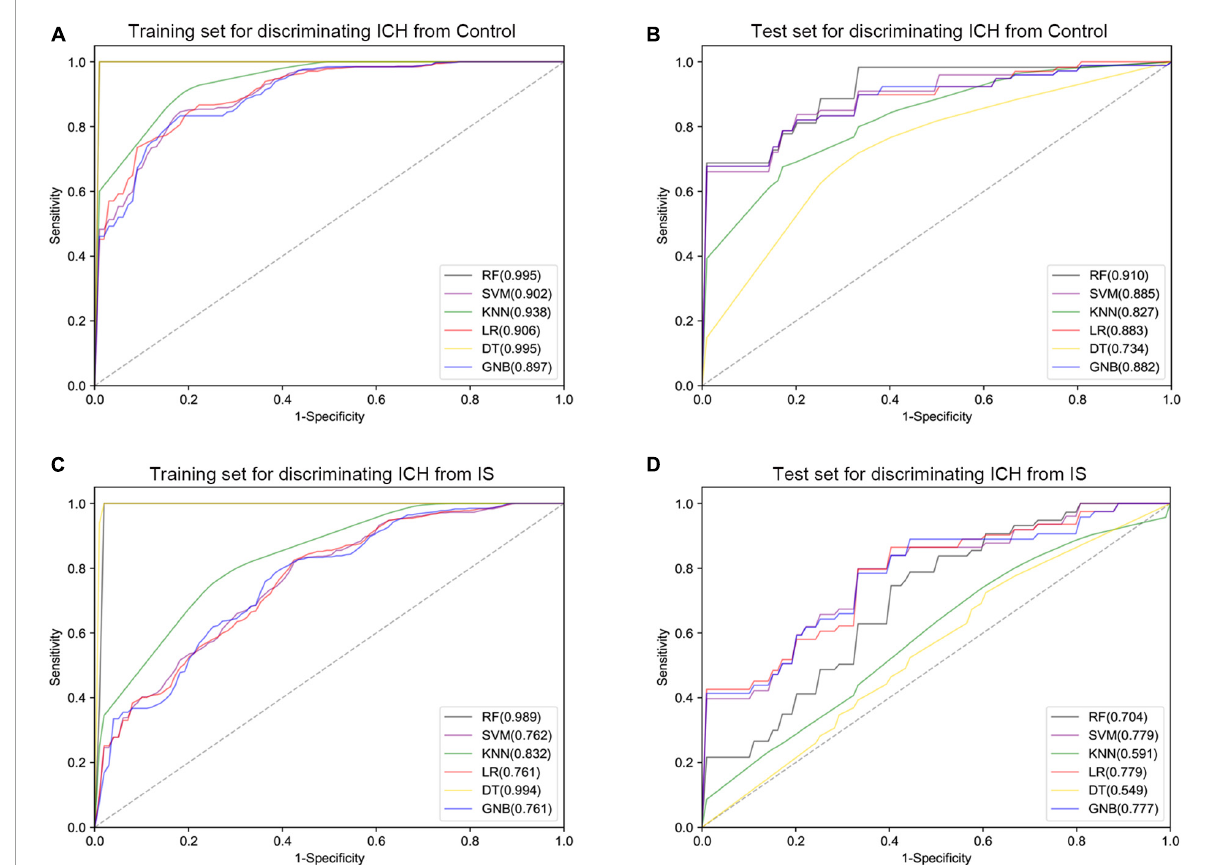
FIGURE6 Receiver operating curve (ROC) plot of the six classifier performances based on AUC in the training set and test set. (A,B) ROC plot of the six classifier performances based on AUC in the training set (A) and test set (B) for discriminating intracerebral hemorrhage (ICH) from healthy controls. (C,D) ROC plot of the six classifier performances based on AUC in the training set (C) and test set (D) for discriminating ICH from ischemic stroke (IS) patients. SVM, support vector machine; RF, random forest; KNN, K-nearest neighbor; LR, logistic regression; DT, decision tree; GNB, Gaussian naive